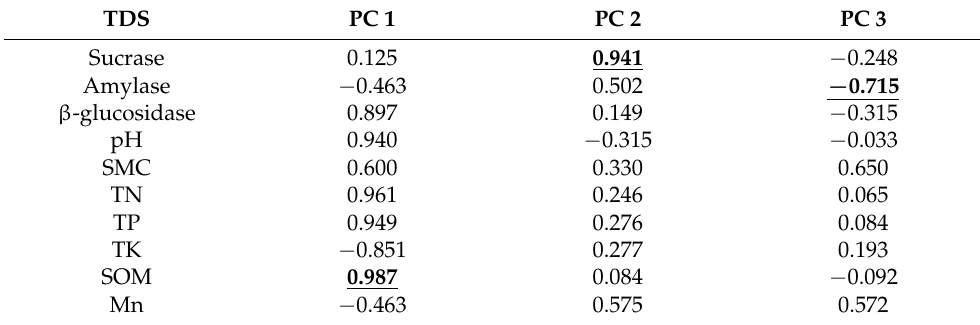
Table 3. Principal component analysis (PCA) load matrix of soil environmental factors.